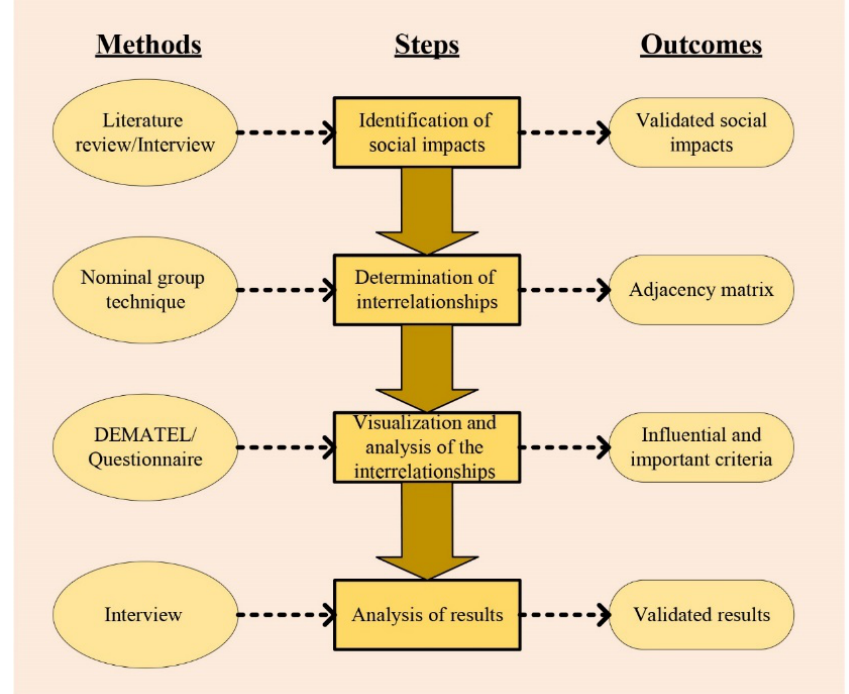
Figure 2. Research